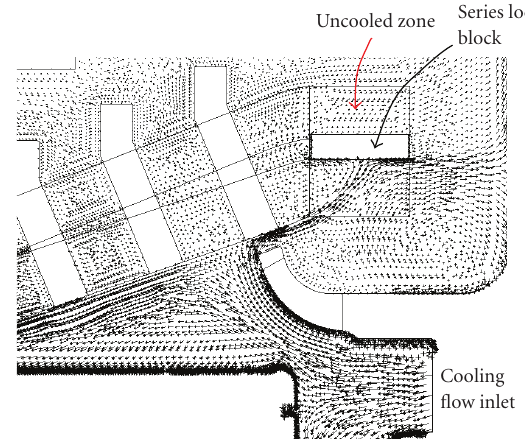
Figure 9: Uncooled zone appearing above the series loop